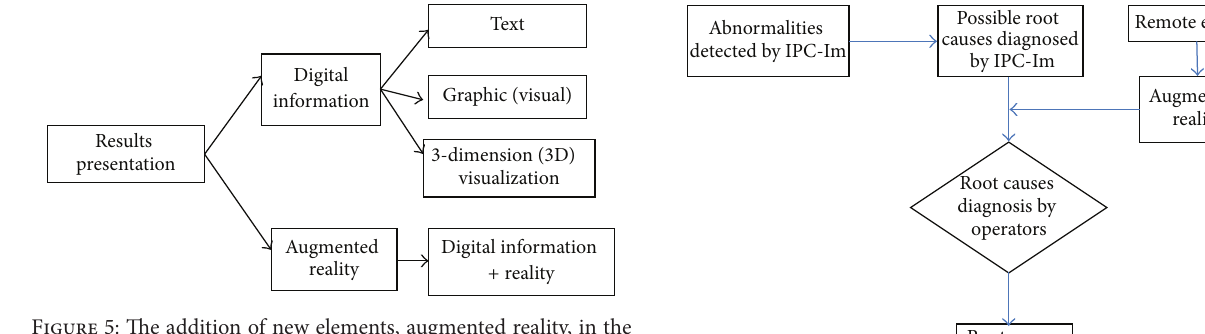
Figure 5: The addition of new elements, augmented reality, in the detection mode of results.